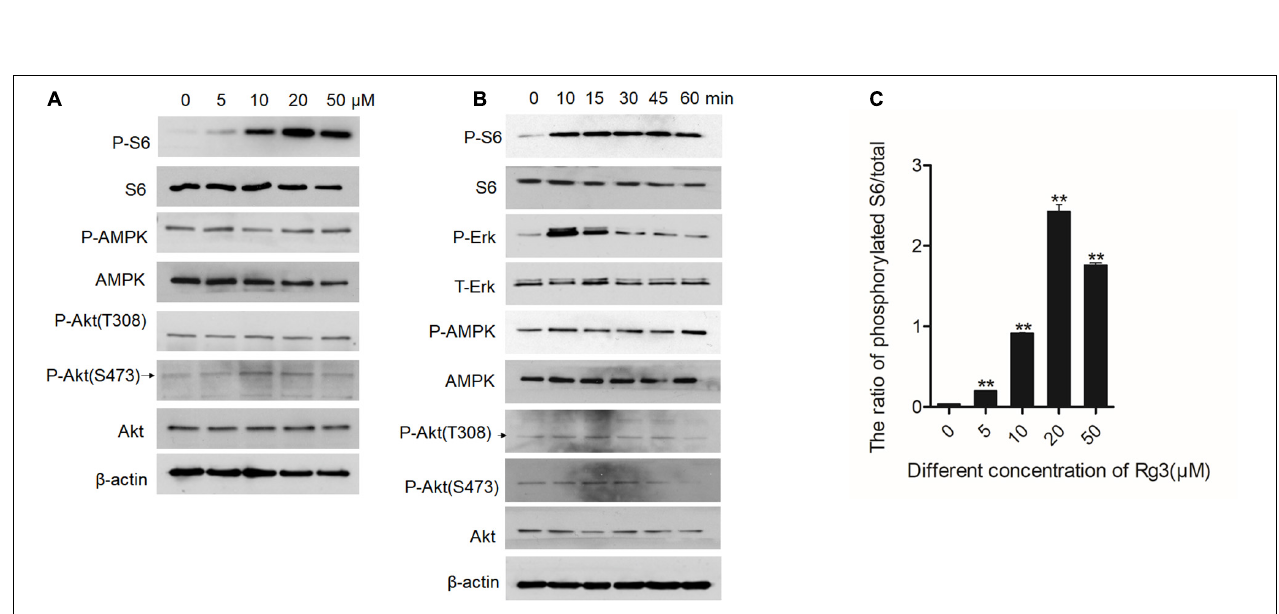
FIGURE 2 | Rg3 activates the mTORC1 and extracellular signal-regulated kinase (ERK)1/2 signaling pathways. Serum starved cells treated with different concentrations of Rg3 for 1 h (A) or 20 µ M of Rg3 for various time points (B) . (C) Quantitative presentation of the relative levels of phosphorylated S6 expressed as the ratio of phospho-S6/total S6. Data are from three independent experiments and expressed as mean ± SD. ** P < 0.01.